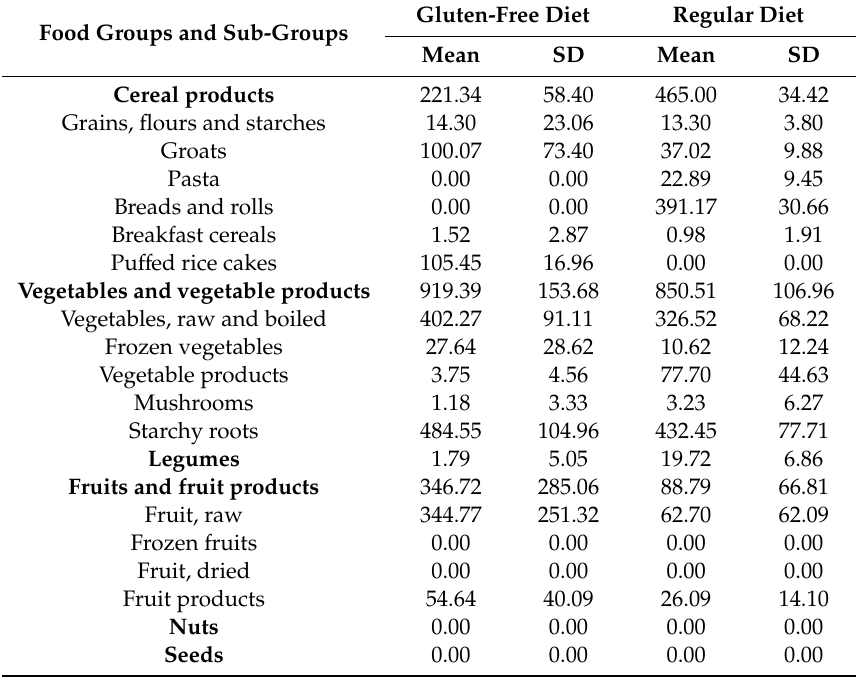
Table 4. Distribution of food group and sub-group consumption (g /